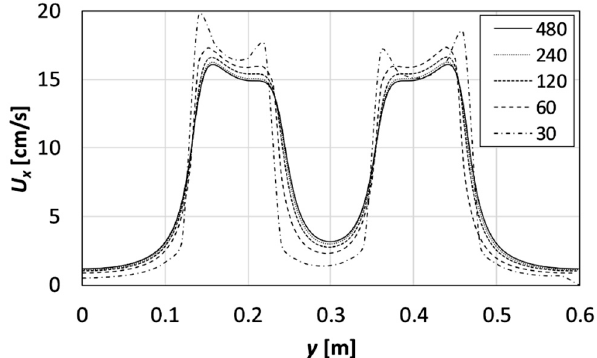
Figure A2. Counter flow configuration at P in = 34.3 kPa: pressure profiles along a line orthogonal to the main flow direction and located 2 cm upstream of the outlet, see Figure 8b. Results obtained with five grids of increasing resolution are reported.